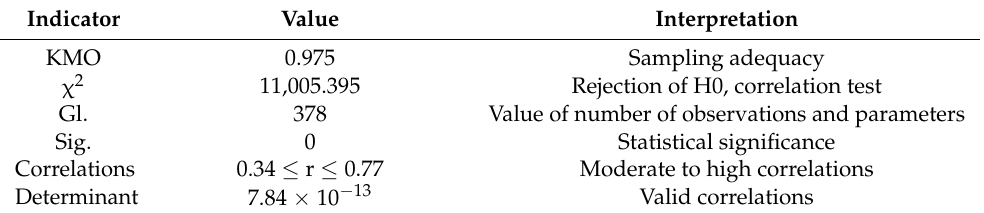
Table 11. Preliminary factorial results of ethical values ineffective communication.